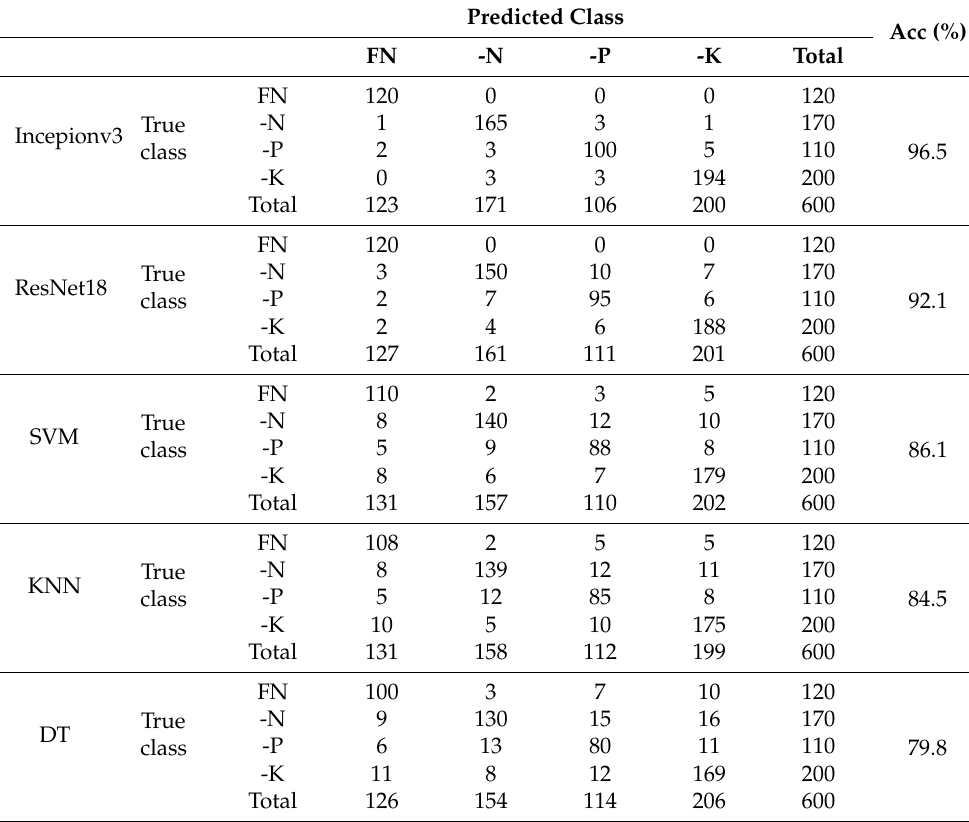
Table 7. Confusion matrices of all classification methods. Inceptionv3, ResNet18, SVM, KNN, and DT.